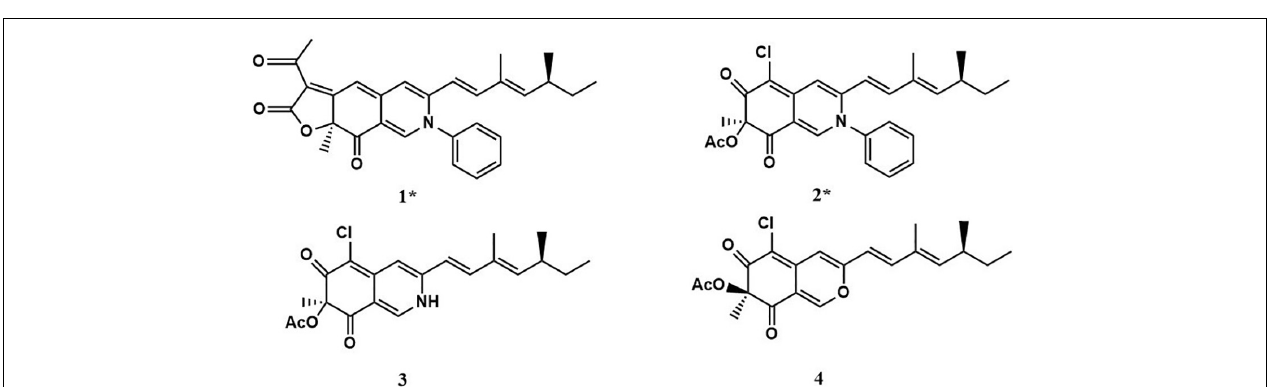
FIGURE 1 | Neighbor-joining tree based on ITS nucleotide